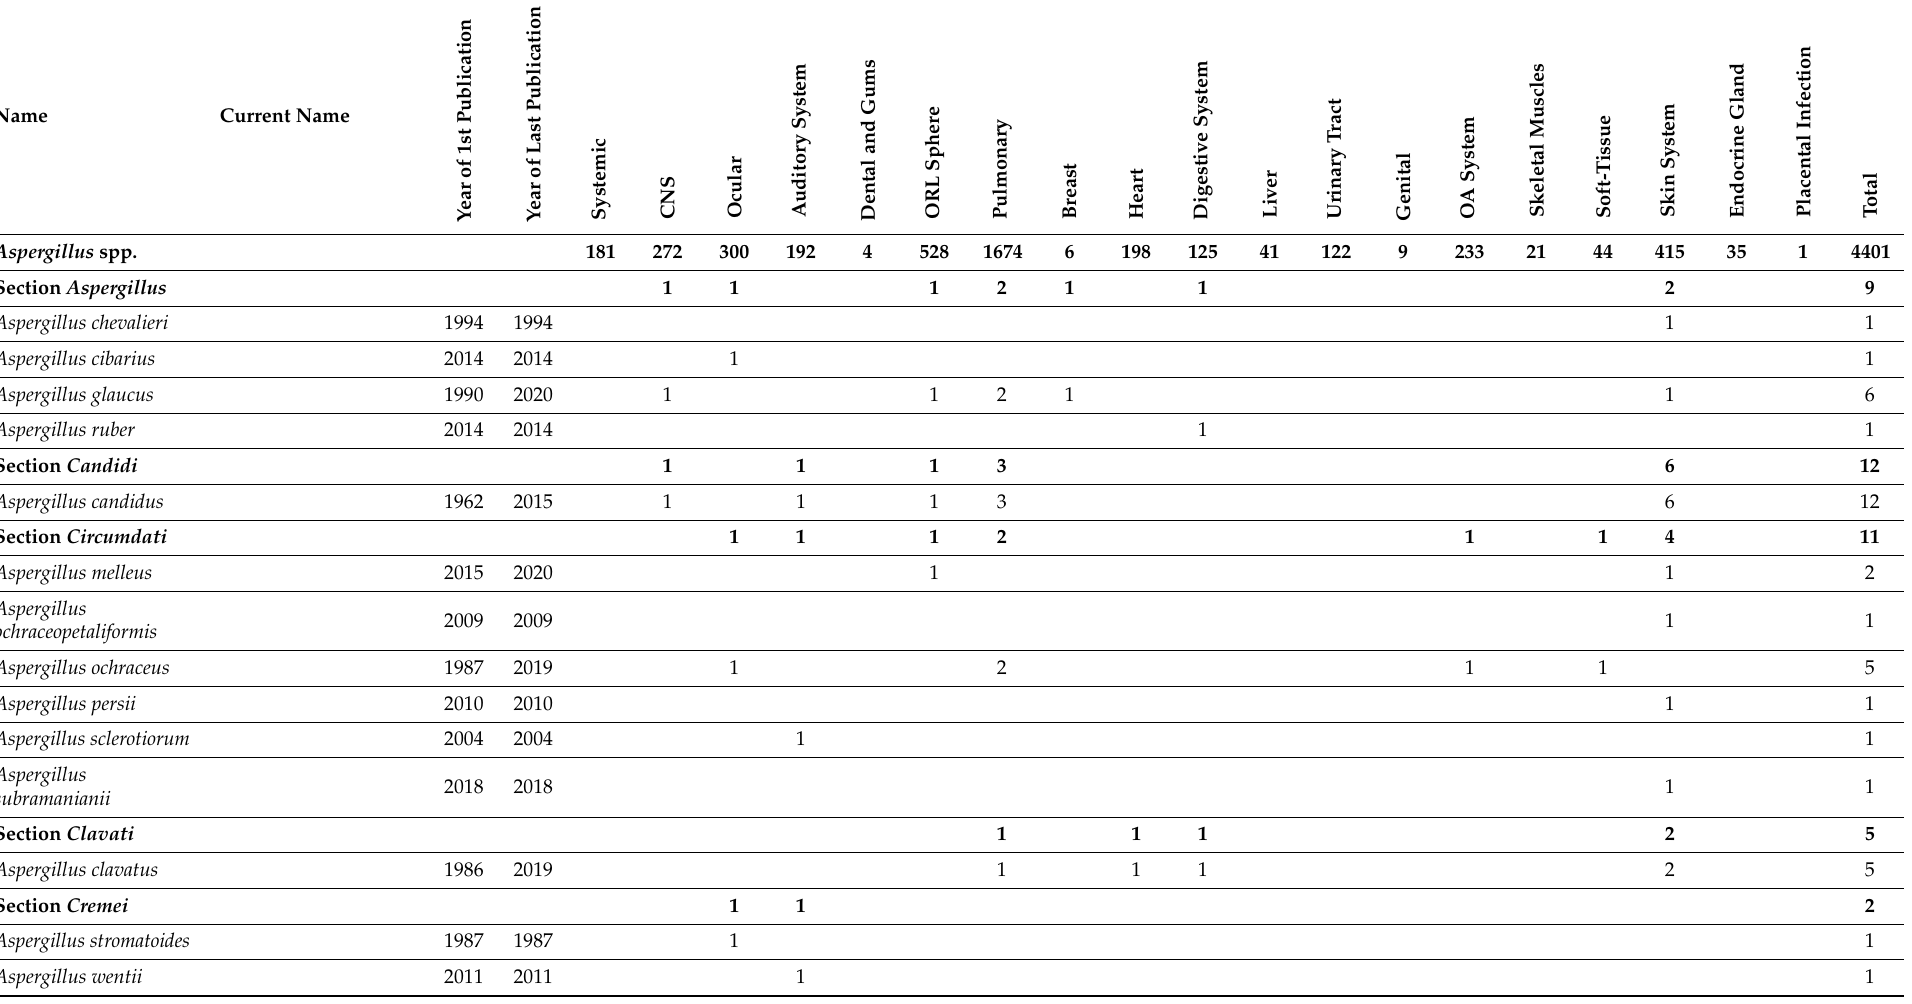
Table 1. Number of publications found by anatomical site and species. In the same publication (PMID), several anatomical sites of isolation could be